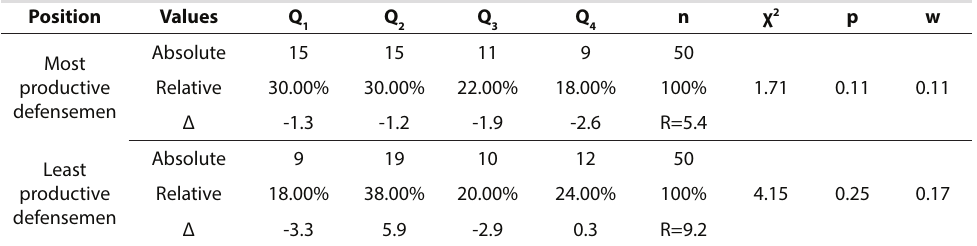
TABLE 5. Comparison of the 50 Most Productive and the 50 Least Productive Defensemen